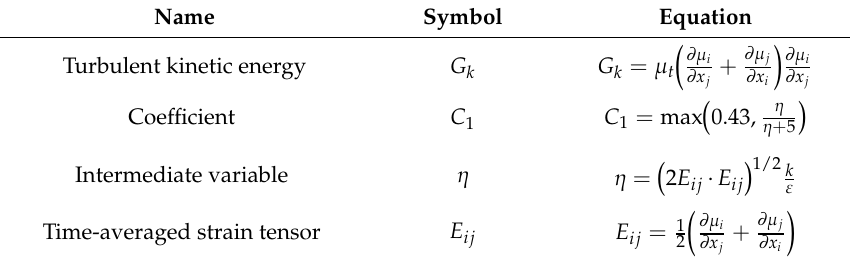
Table 2. Some key parameters of the realizable k − ε turbulence